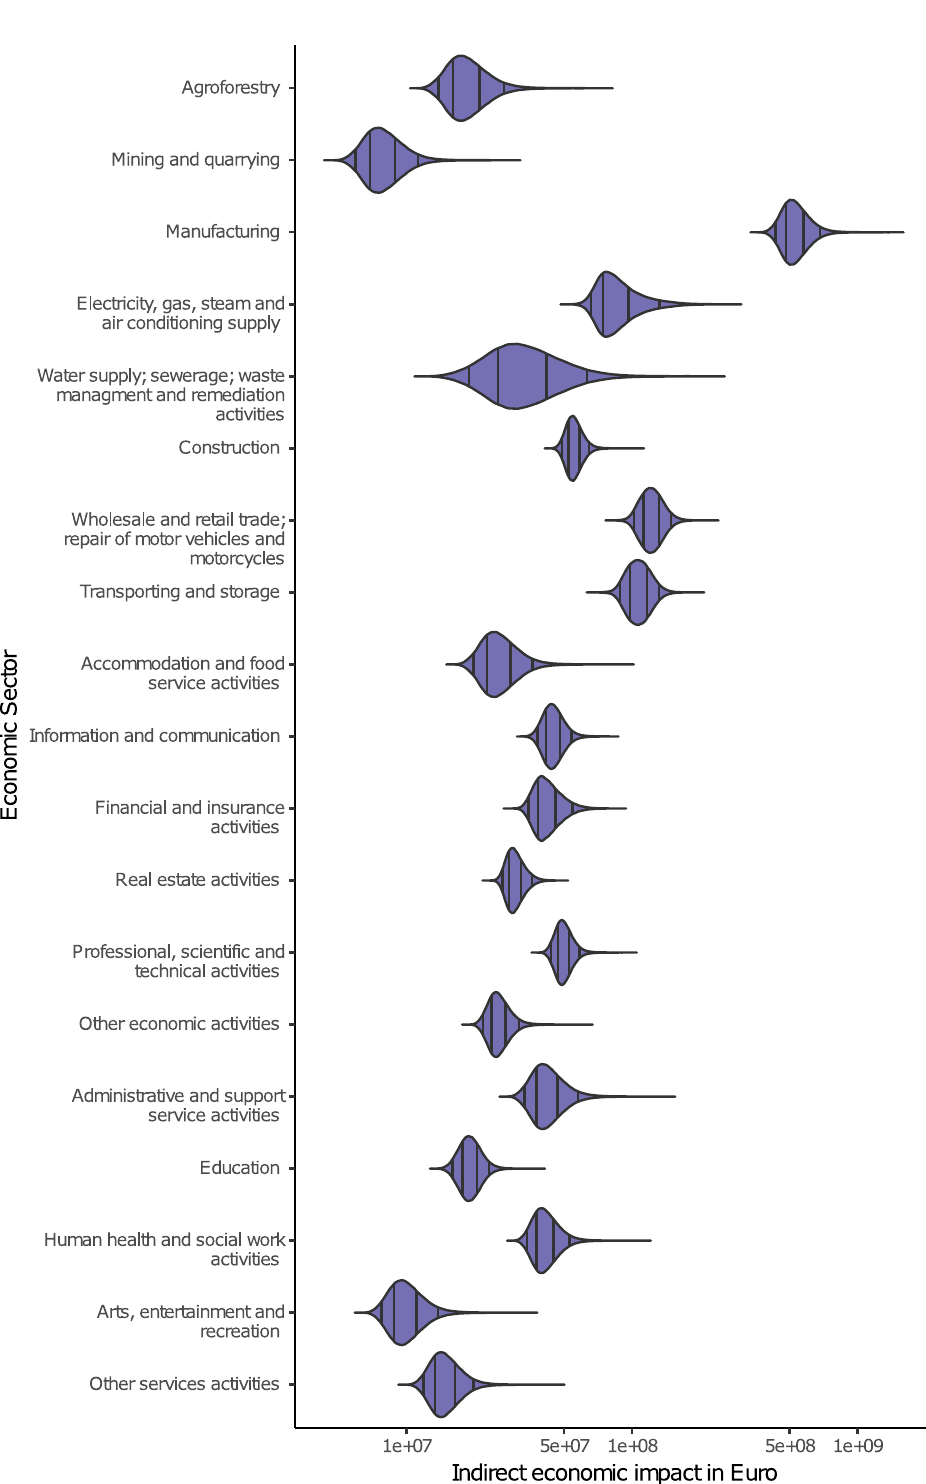
PLOS ONE | https://doi.org/10.1371/journal.pone.0212932 April 4,